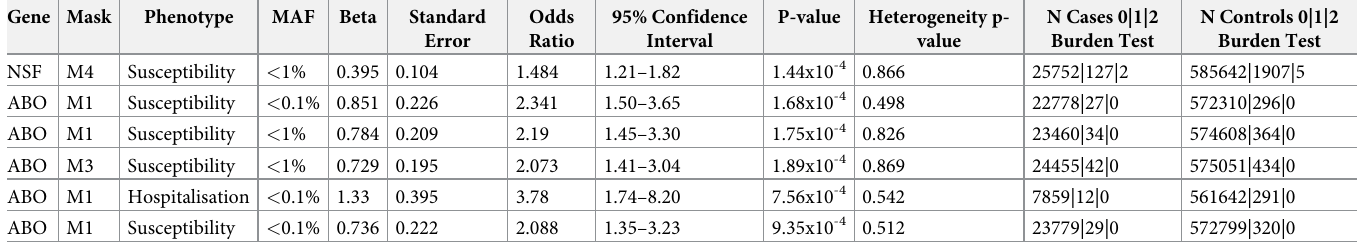
Table 2. Results of burden tests at genes identified from common variants GWAS in the COVID-19 HGI. Only genes with p < 0.05/46 are shown here. Full results available in S8 Table . Gene Mask